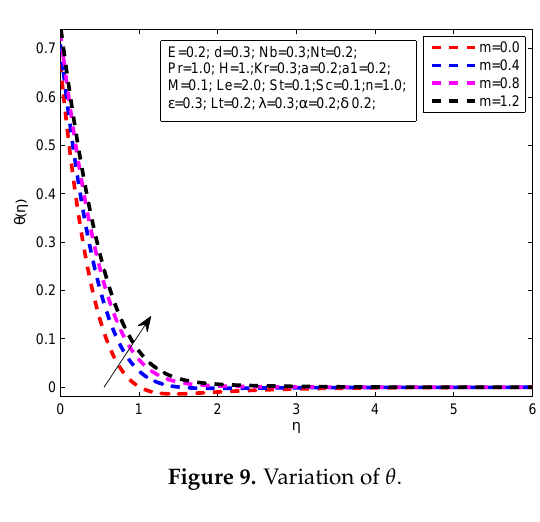
Figure 8. Influence of m on f (cid:48) .